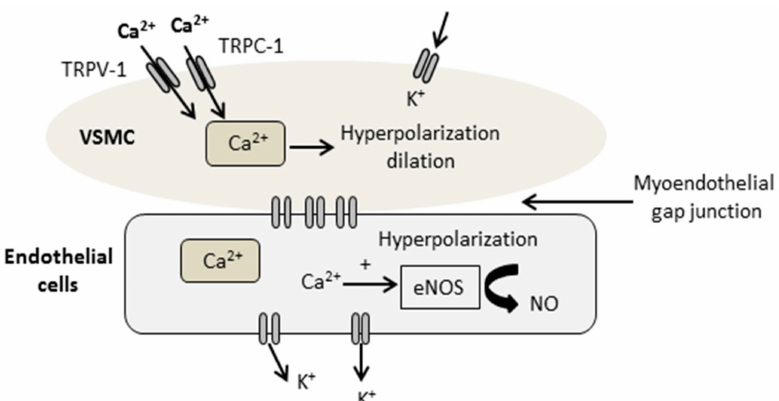
Figure 1. Schematic diagram showing the activation of the non-selective cation channels, transient receptor potential canonical (TRPC-1), increasing calcium (Ca 2+ ) influx into the vascular smooth muscle cells (VSMC) and endothelial cells. Displayed data suggests that calcium influx induces the upregulation of endothelial nitric oxide synthase (e-NOS) and nitric oxide (NO) release, promoting endothelial protective effects.